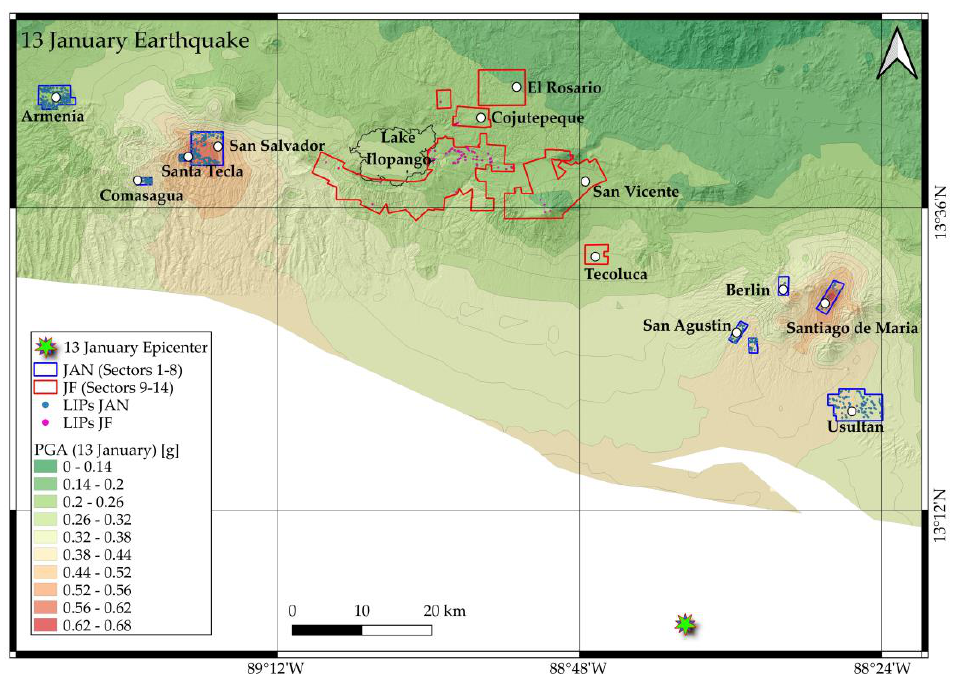
Figure 6. PGA values and LIPs related to the seismic event of Mw 7.7 on 13 January 2001 in the fourteen study areas.